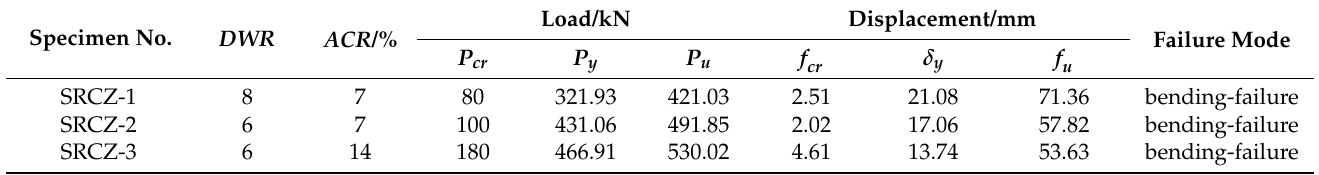
Table 3. The Experimental Loads, Corresponding Displacements and Failure